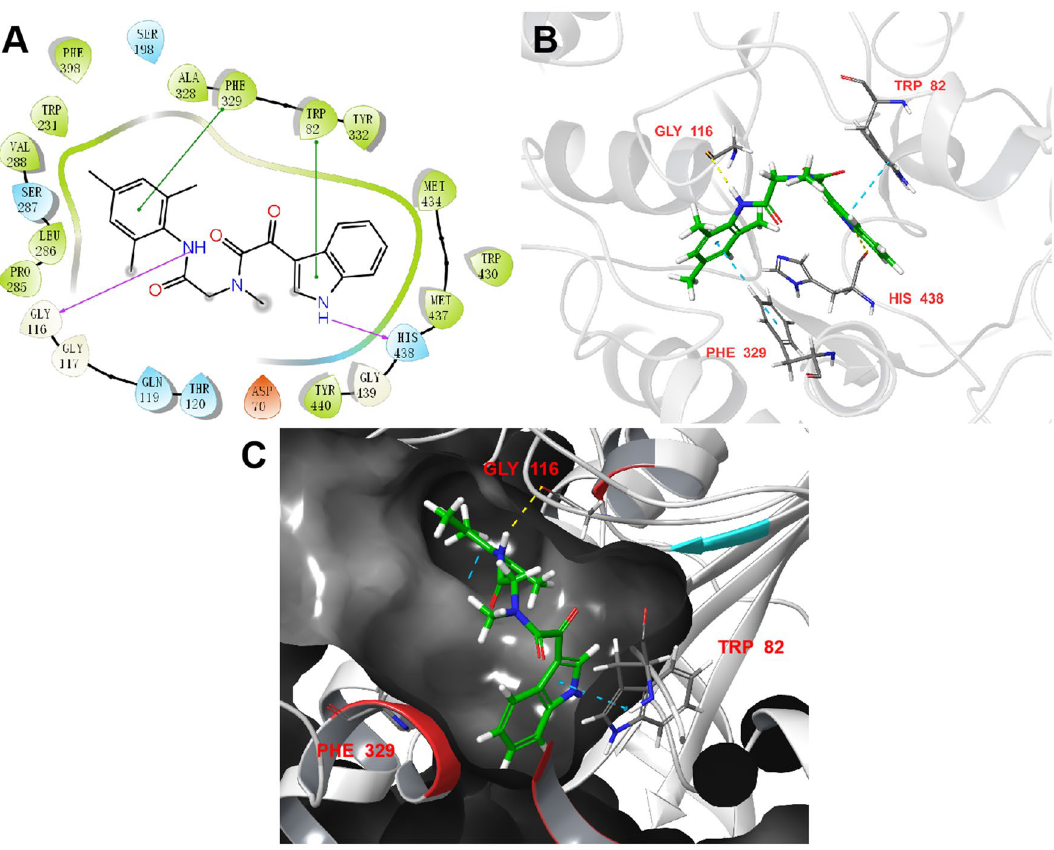
Figure 3. Docking pose of 8c into active site of BChE (PDB ID 4TPK). ( A ) 2D binding mode of 8c with BChE. Hydrogen bonds were shown as purple lines, π–π stacking interactions were in green lines. ( B ) interacting residues of BChE were shown in sticks colored by atom type, the carbon in green, hydrogen in white, nitrogen in blue and oxygen in red. Interactions included non-covalent bonds and π interaction, the hydrogen bonds in yellow, π–π stacking in blue. ( C ) 3D complex structure of molecule 8c with